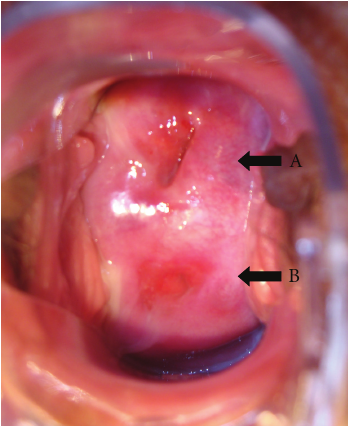
Figure 1: Picture of the dual cervix (black arrows A, B). Both cer- vices are situated in an anteroposterior disposition. A reddish endo- cervical epithelium can be clearly seen surrounding both external os.